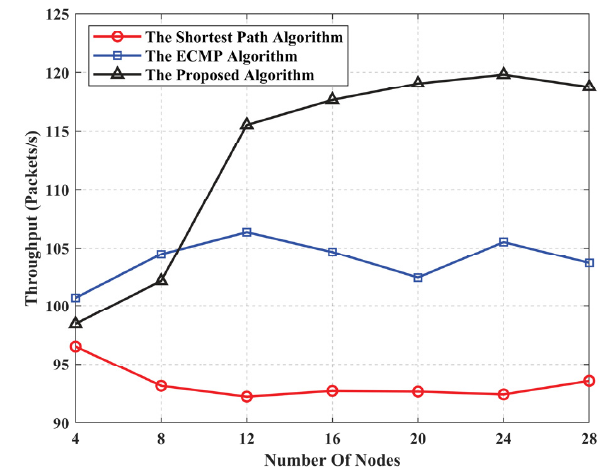
Figure 12. Throughput at di ff erent topology sizes.